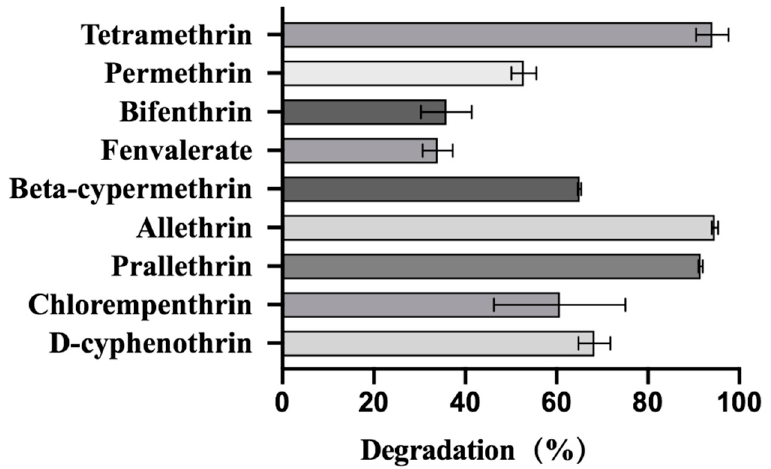
Figure 6. Degradation of various synthetic pyrethroid insecticides by strain A16.